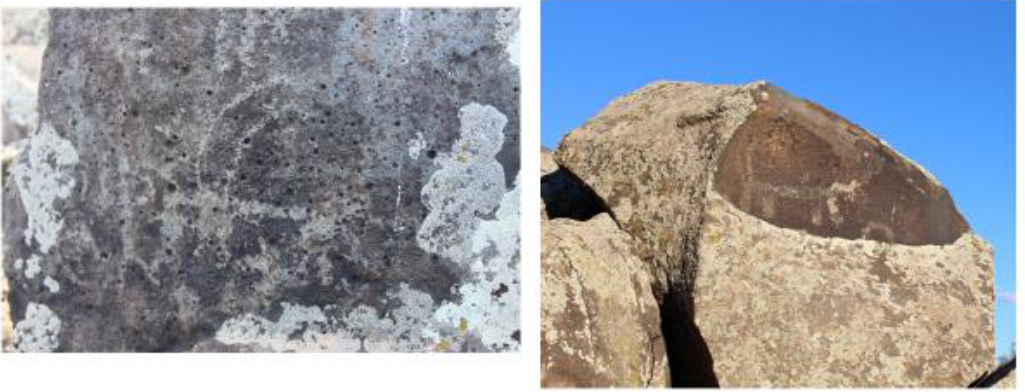
Figure 28. Lernamerdz. Manifestation of prehistorical activities.